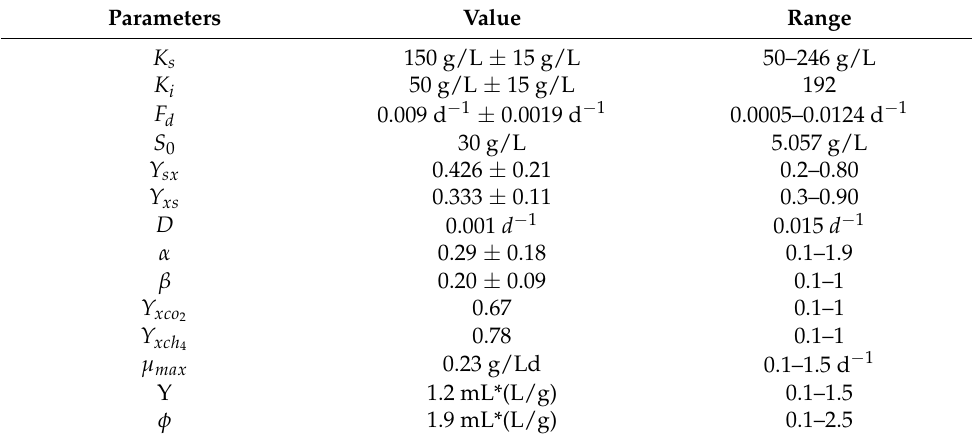
Table 1. Simulation parameters obtained from the literature [34,35].